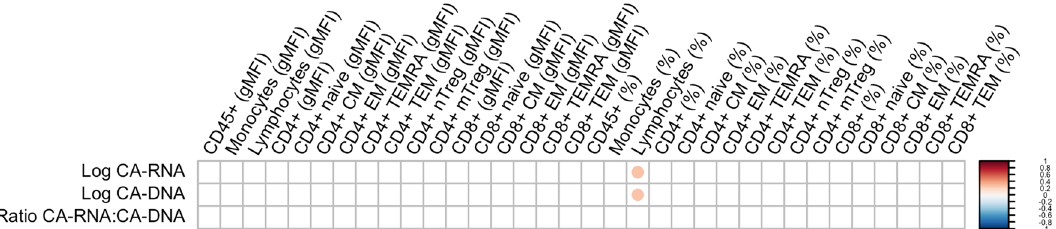
Figure 3. Spearman’s rank correlation plot of viral reservoir parameters with CCR5 expression (MFI and %) on various immune cell subsets. Correlation coefficients were adjusted for age, sex and CMV-serostatus. The size of the circles and the depth of the colour represent the strength of the correlation, while the direction is indicated by colours: red for a positive correlation and blue for a negative correlation. A blank square represents the absence of a significant correlation, while a coloured square represents a significant correlation (FDR-corrected p value <